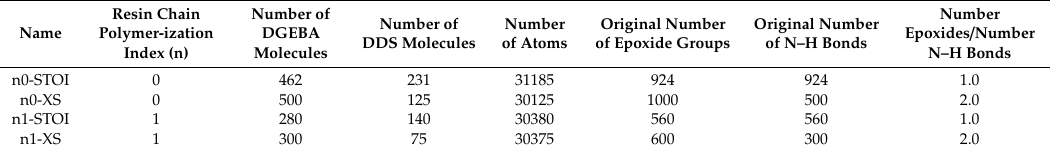
Table 1. Summary of system ingredients prior to crosslinking: 100% excess epoxy and stoichiometric formulations are indicated by “XS” and “STOI”, respectively. Resin molecule degrees of polymerization is designated by “n0” and “n1”.